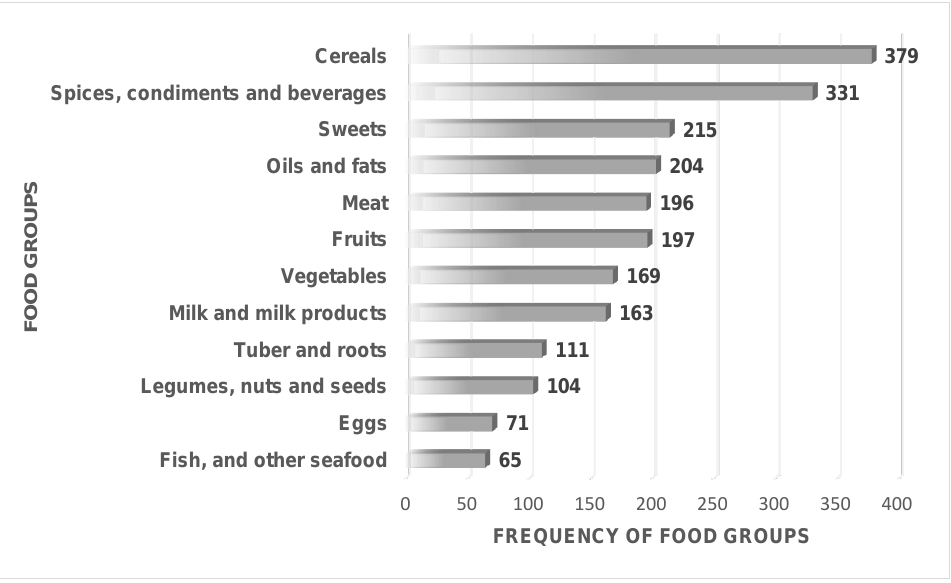
Figure 1. Food groups consumed by children.